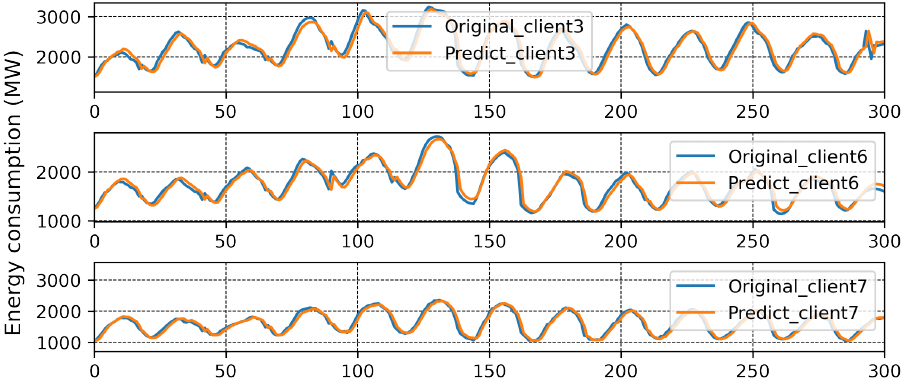
Figure 12. Prediction result when Branches 2 and 4 were merged together.